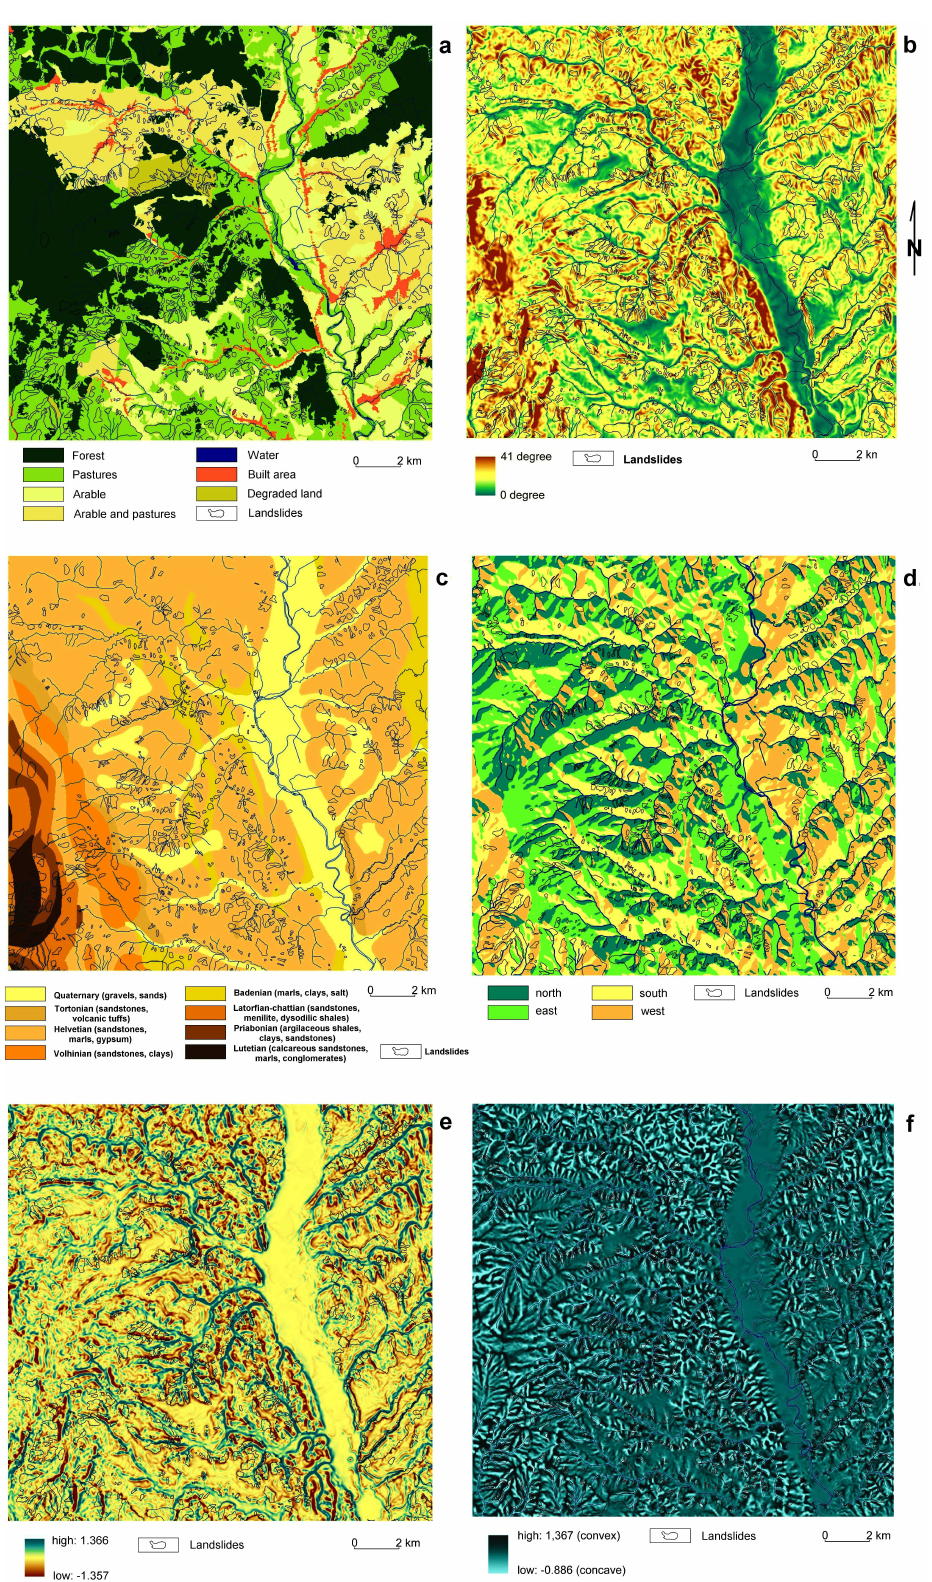
Fig. 8. Significant predictors for the Helegiu sector: (a) land use; (b) slope angle; (c) lithology; (d) slope aspect; (e) profile curvature; (f) plan